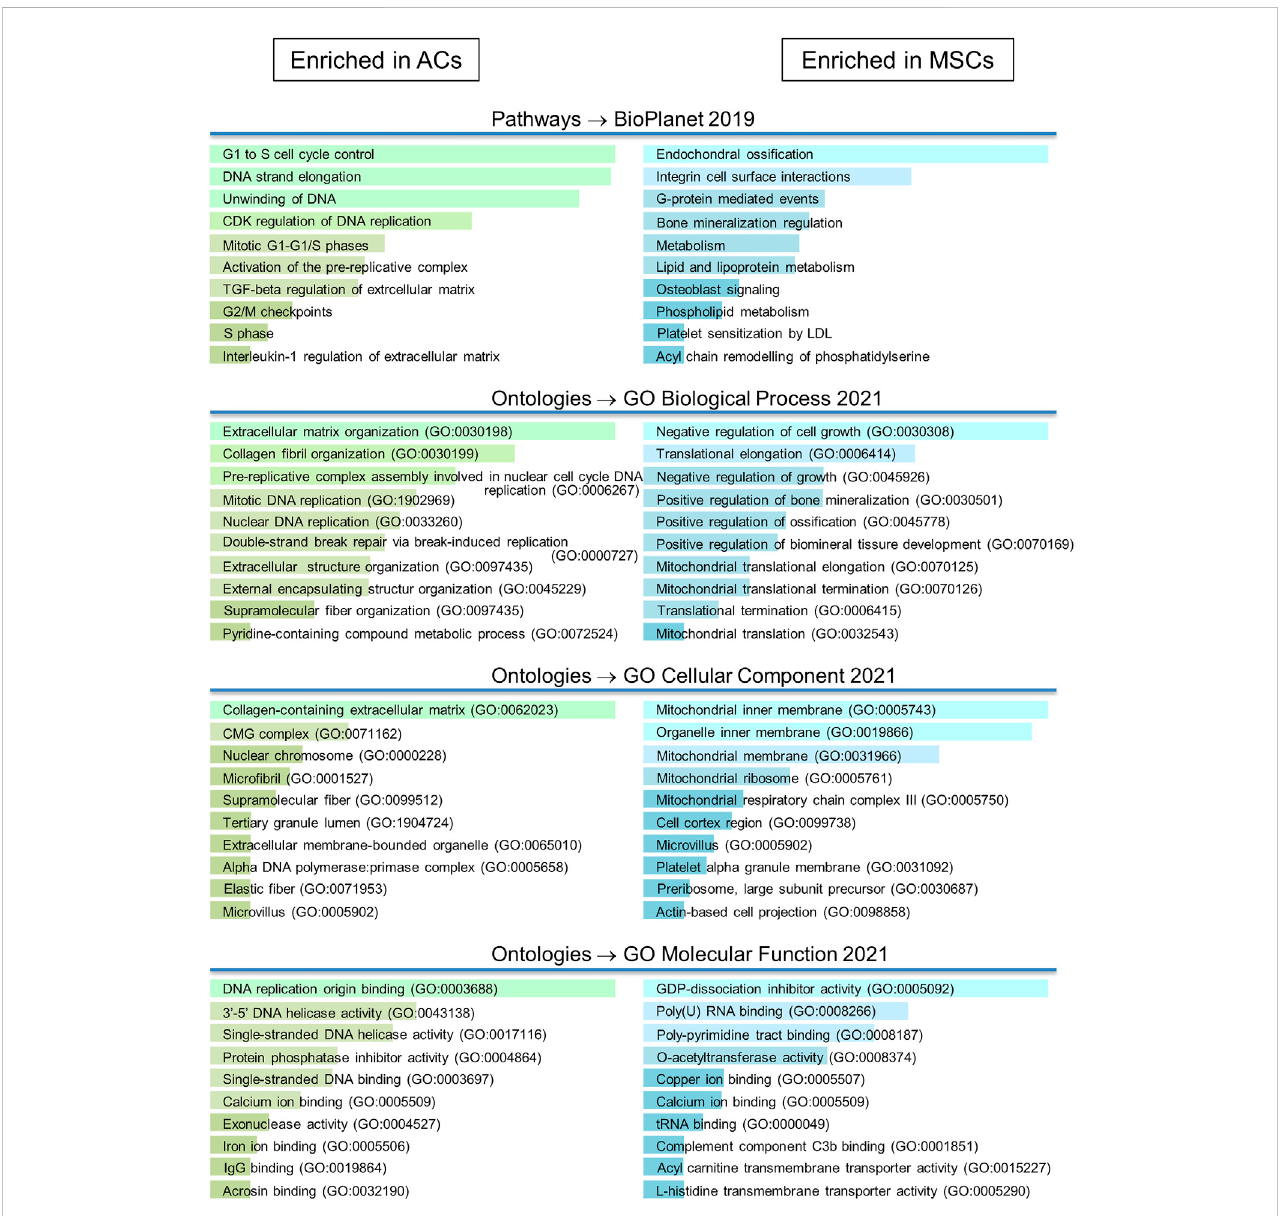
FIGURE 6 Gene ontology/pathway analysis. Differentially expressed proteins were uploaded in Enrichr. More detailed results from GO/pathway analysis can be found in Supplementary Table S3.